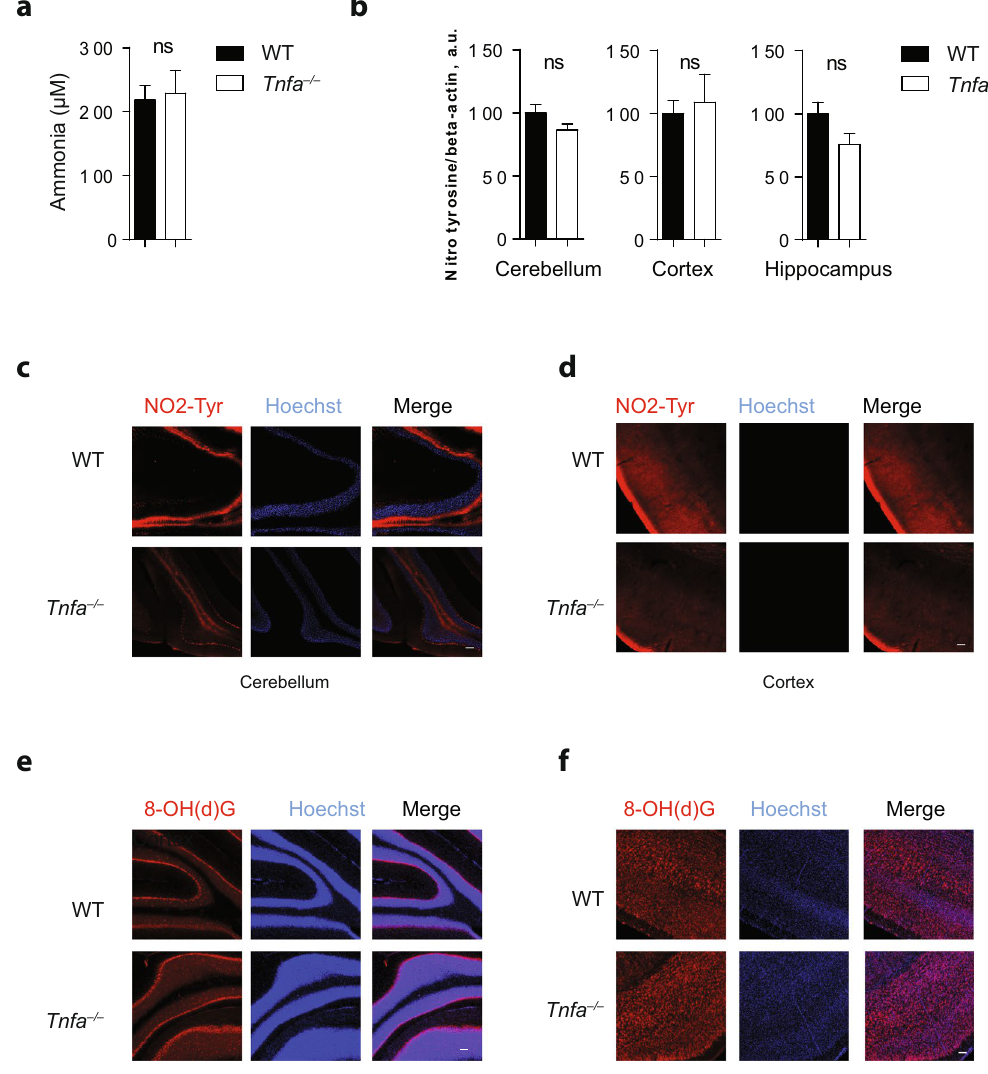
Figure 3. Normal tyrosine nitration and RNA oxidation in brain tissues from Tnfa − / − mice. (a) Ammonia levels were measured in cerebrospinal fluid samples of WT and Tnfa − / − mice (n = 4–6). (b) Protein lysates harvested from the cerebellum of WT and Tnfa − / − mice were blotted and stained using anti-nitrotyrosine and anti-beta-actin antibodies, panel illustrates the densitometric analysis of nitrotyrosine/beta-actin (n = 17). (c – d) Sections from snap frozen ( c ) cerebellum or ( d ) cortex of WT and TNF α deficient mice were stained with anti- nitrotyrosine antibodies (red) and Hoechst (blue). One representative of n = 6 is shown, scale bar = 100 µ m. (e – f) Sections from snap frozen ( e ) cerebellum or ( f ) cortex of WT and TNF α deficient mice were stained with anti-8-OH(d)G antibodies (red) and Hoechst (blue). One representative of n = 6 is shown, scale bar = 100 µ